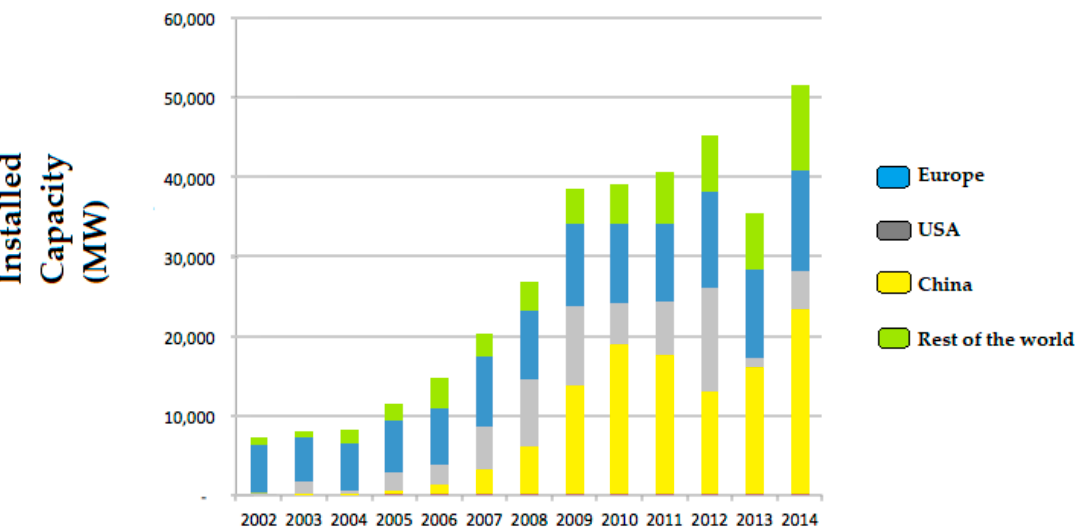
Figure 4. Annual installed capacity by region (Data source [43,44]).